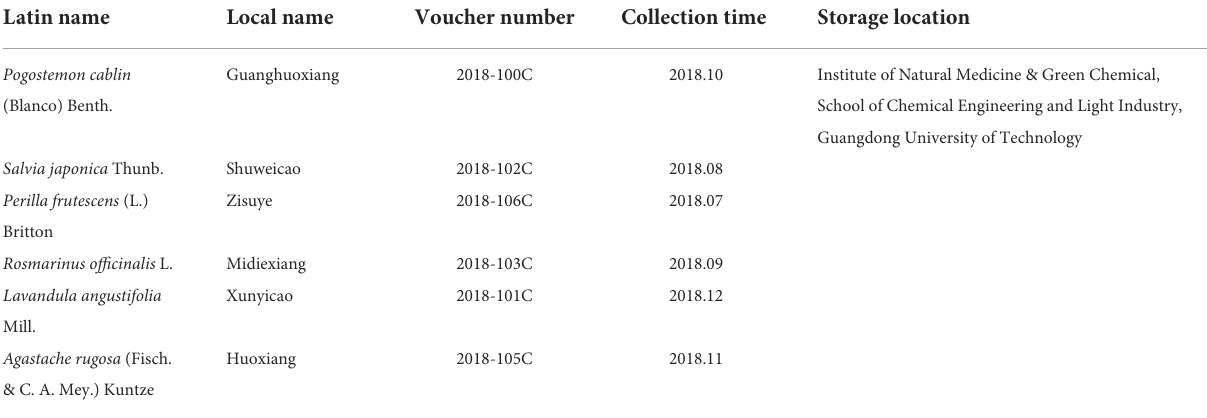
TABLE 1 Latin name, local name, voucher specimen number, and collection time of six Lamiaceae